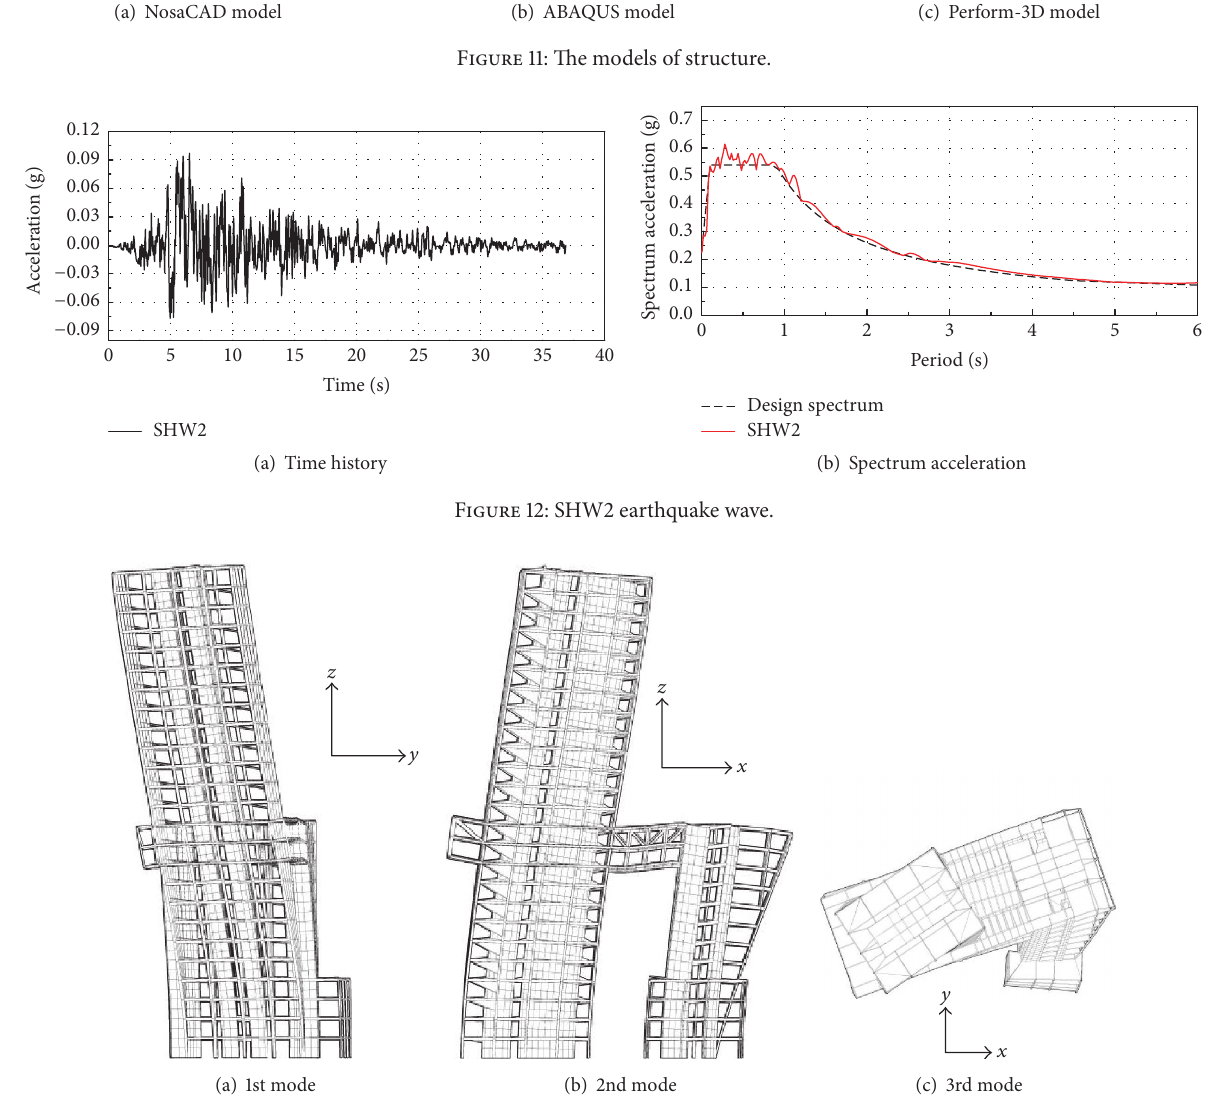
Figure 13: First three mode shapes in